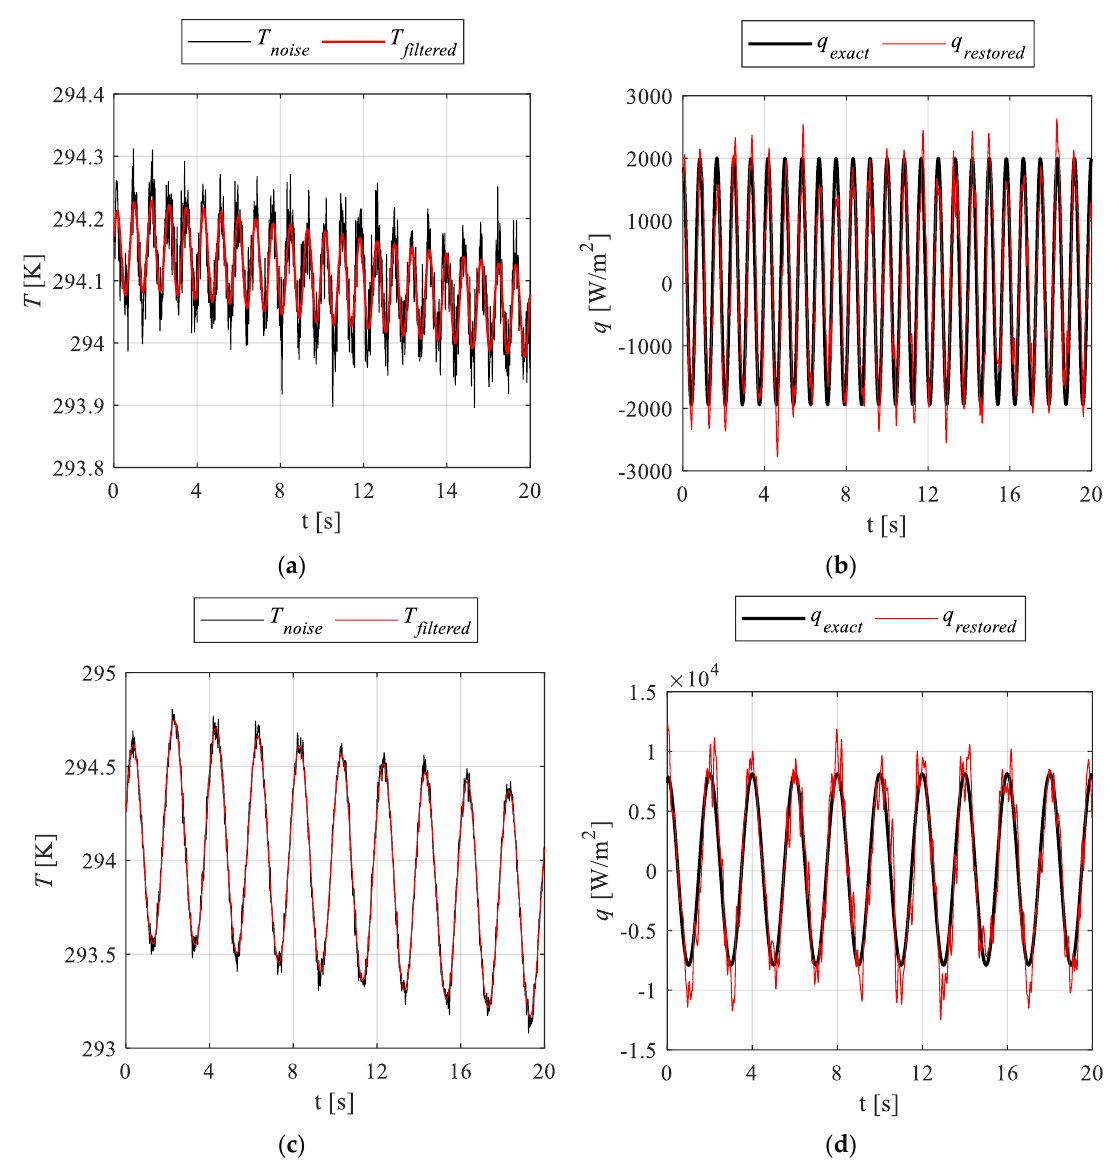
Figure 5. Noisy and filtered temperature signals ( σ = 0.04 K, z = 0.02 m) for Amp = 2000 W/m 2 , f = 1.2 Hz ( a ), and Amp = 8000 W/m 2 , f = 0.5 Hz ( b ), and corresponding exact and restored heat fluxes ( c , d ), respectively. The fixed axial coordinate z = 0.02 m is considered.